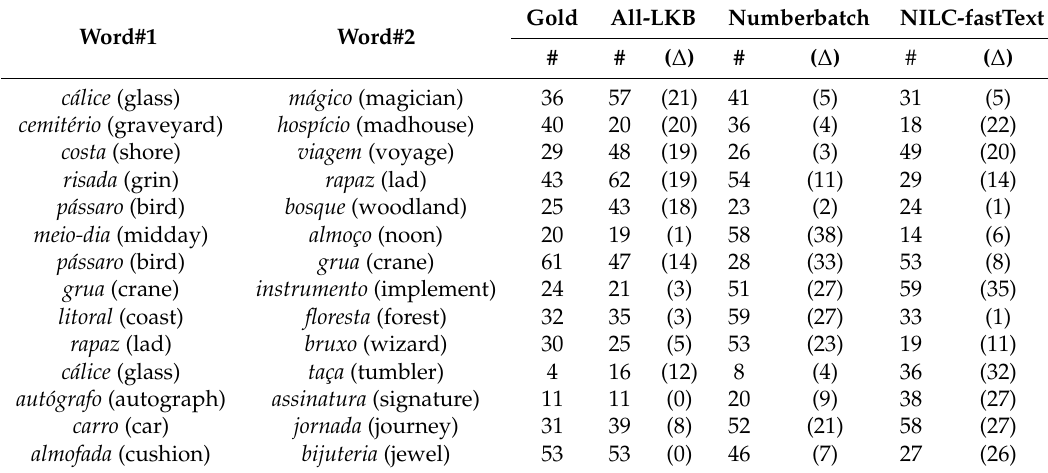
Table 13. Word pairs with higher rank difference ( ∆ ) in procedures using three different databases and gold score in PT-65.